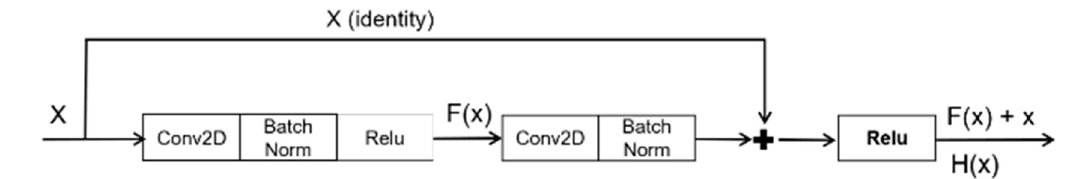
Figure 3. Schematic diagram of the residual block.